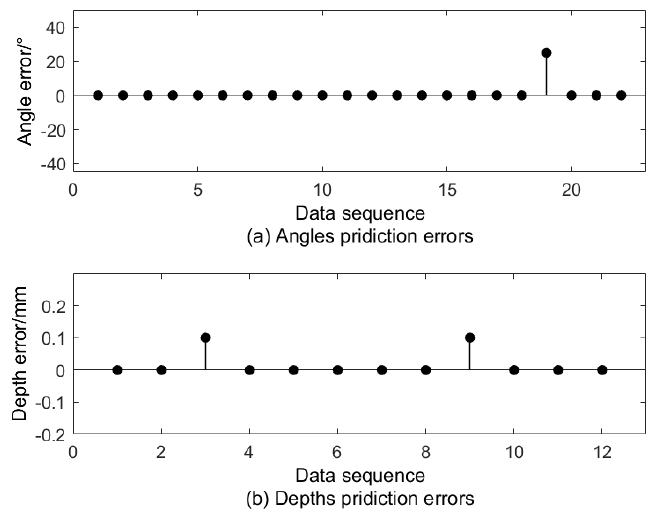
Figure 28. ( a , b ) prediction errors.